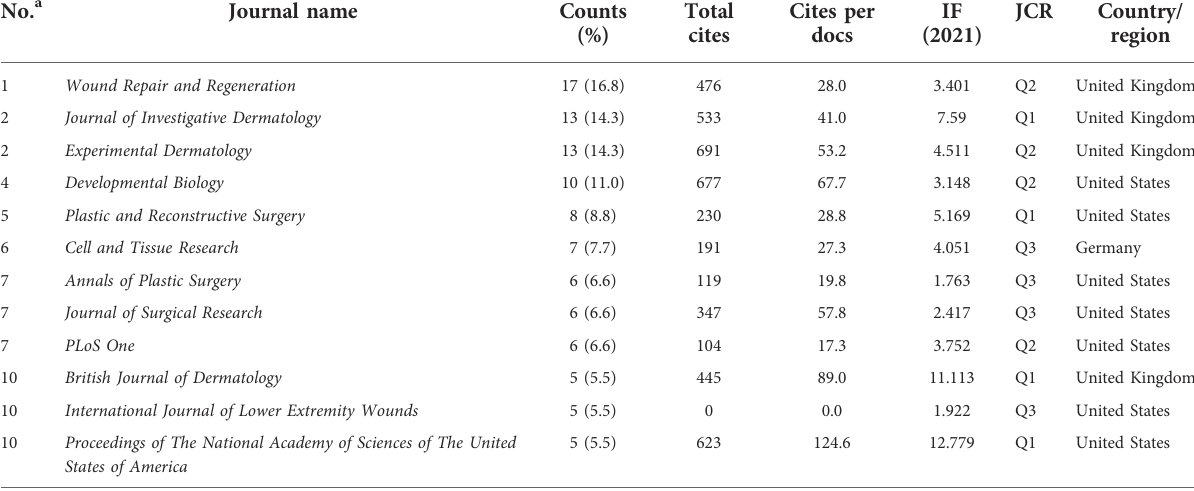
TABLE 2 Top 10 journals that published research on skin innervation effects on wound